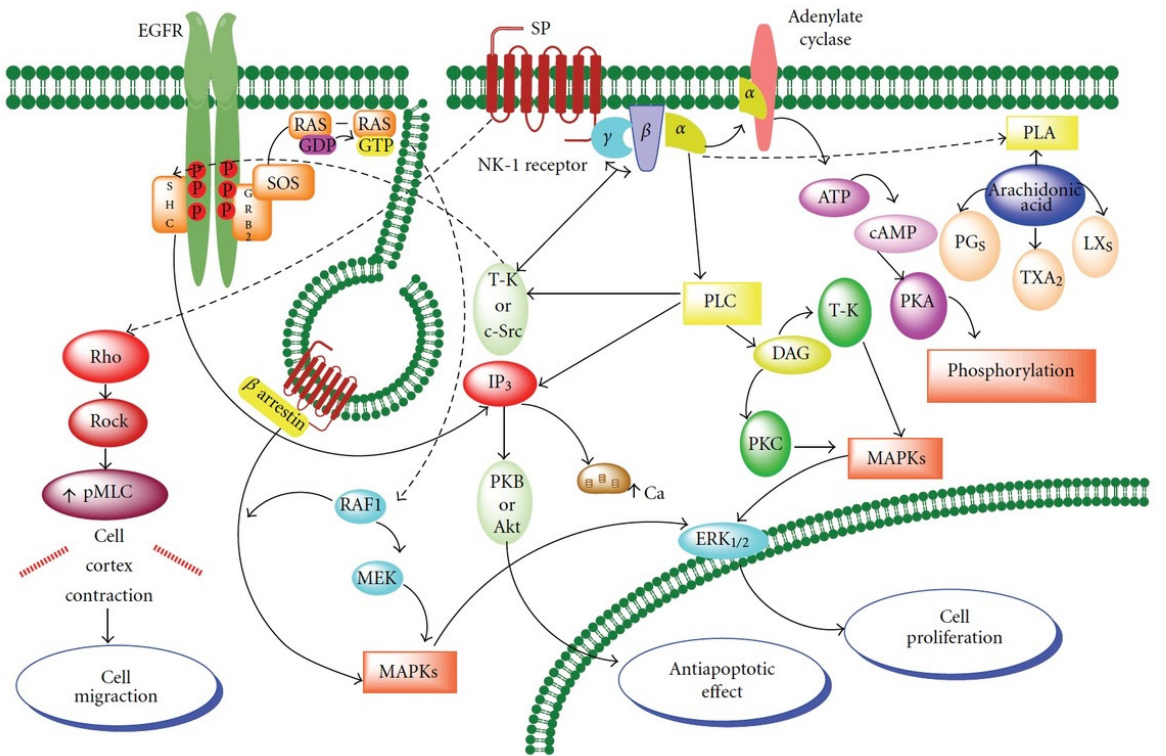
Figure 1. Signalling pathways of SP binding to the NK1 receptor. Cell proliferation, inhibition of apoptosis and migration after activation of NK1R by SP (Adapted with permission from Ref. [58]. 2012 Rosso, M. et al. Previously modified from Ref. [64]. 2010 Munoz, M. et al. ).